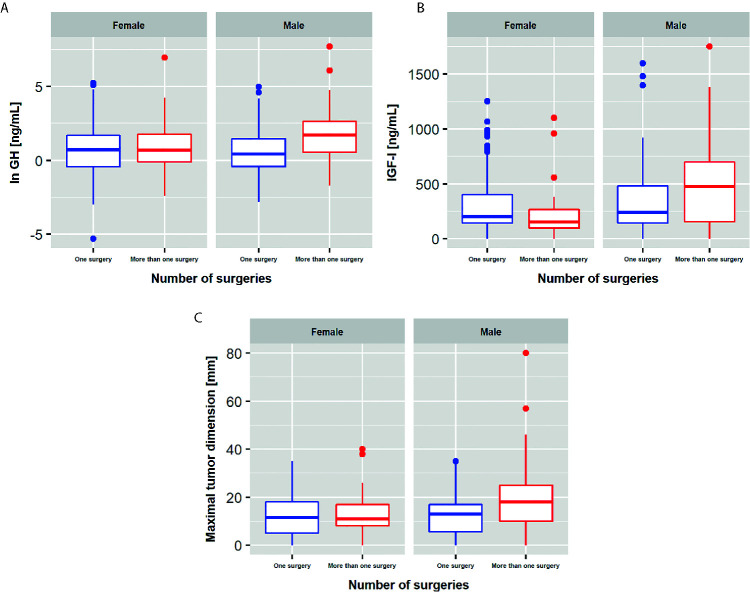
Differences between patients operated once and patients with reoperations. (A) GH concentrations; (B) IGF-I concentrations; (C) maximal tumor dimensions.